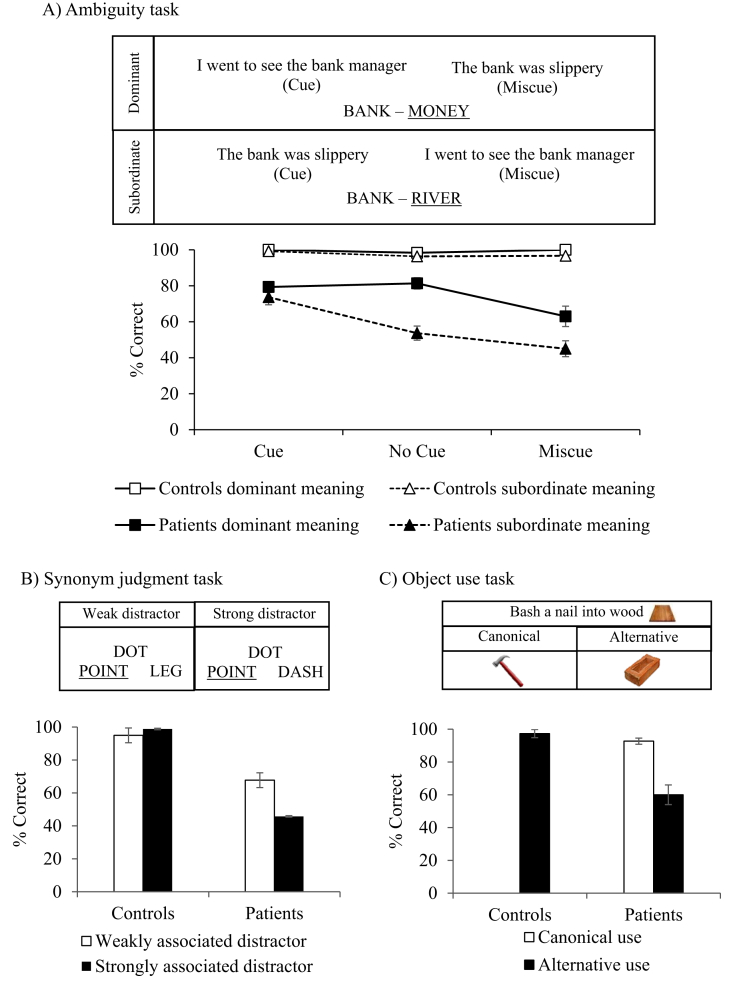
Tests manipulating semantic control. (A) Ambiguity task, from Noonan et al. (2010). (B) Synonym judgement task, from Samson et al. (2007). (C): Object use task, from Corbett et al. (2011). Error bars show SE of mean.